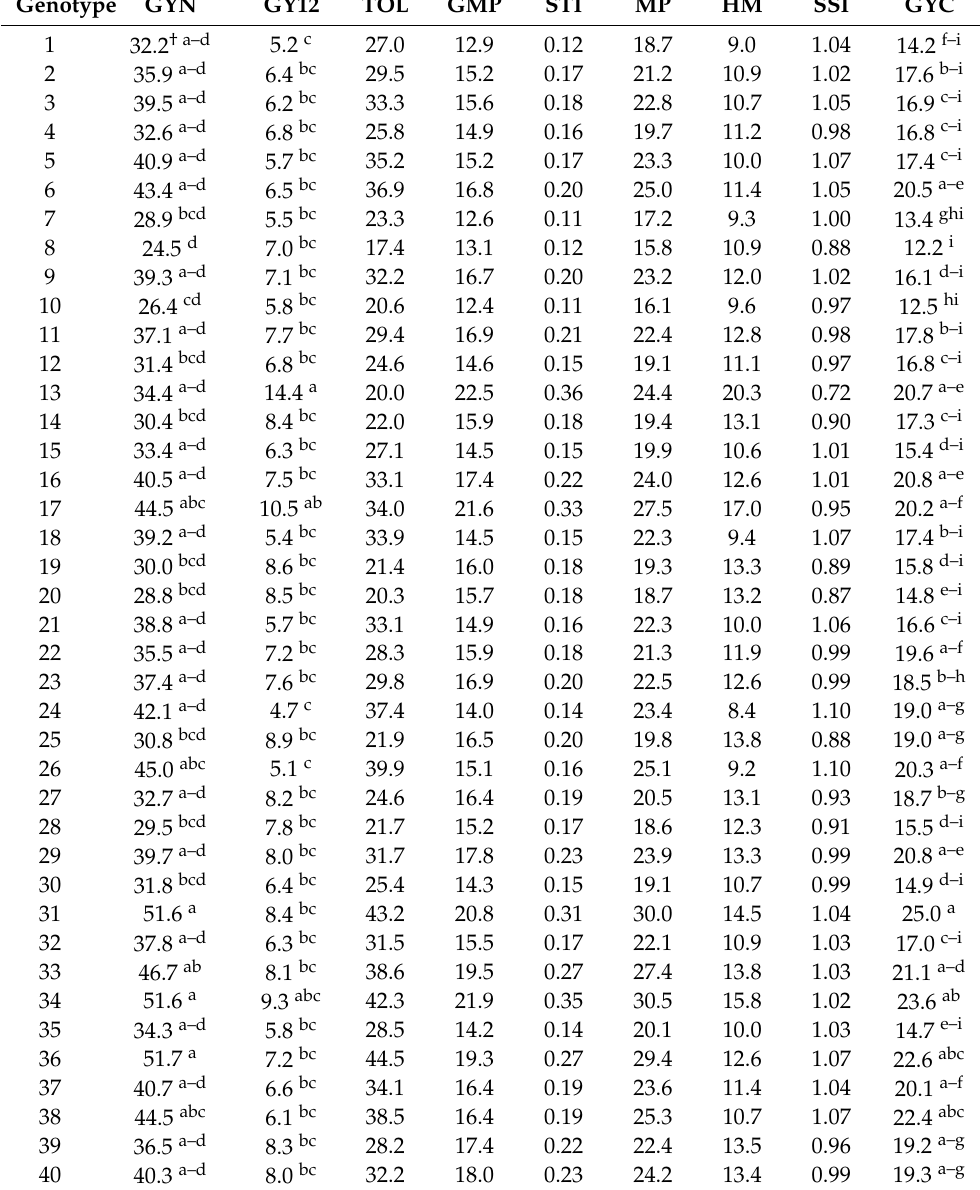
Table 6. Grain yield of control (GYN), grain yield at 12.0 dS/m (GY12) treatment, and salinity tolerance/susceptible indices along with grain yield combined data (GYC) of forty genotypes in 2019/20